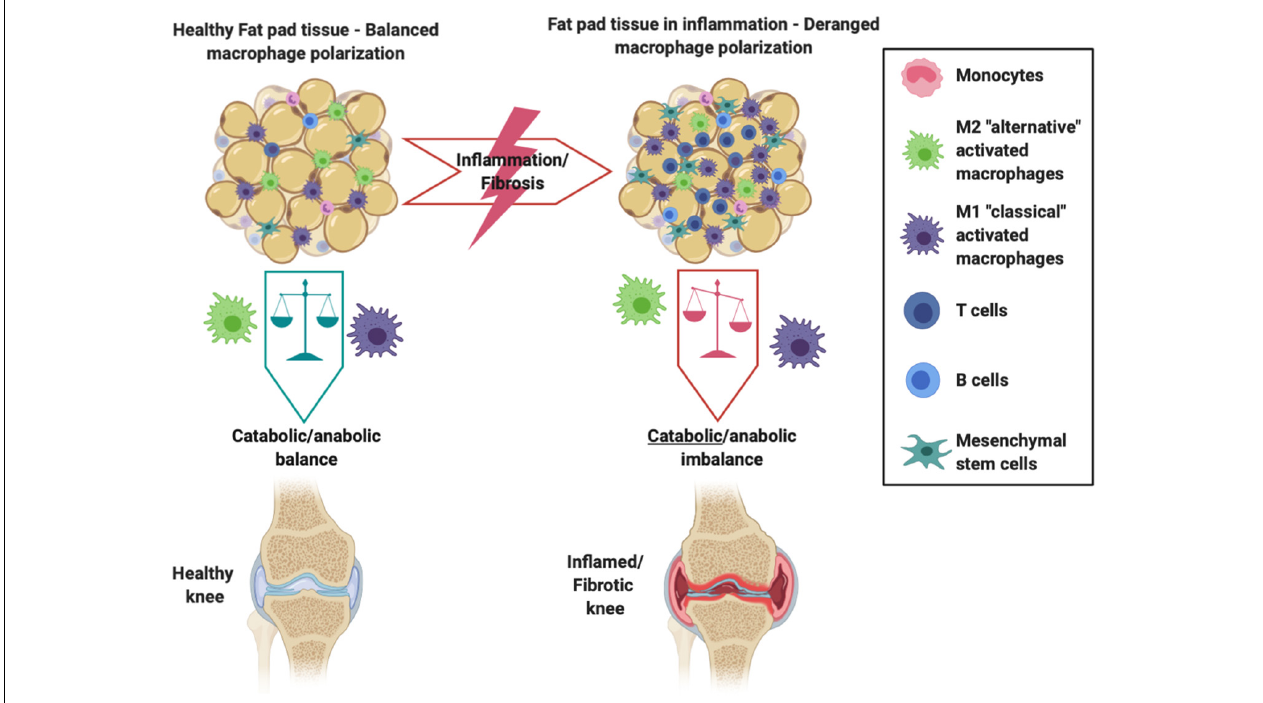
FIGURE 2 | Schematic showing the intricate balance between M1 and M2 macrophages within the IFP and synovium. Differentiated M2 macrophages exhibit anti-inflammatory effects and preserve the health of the joint, whereas an imbalance favoring M1 macrophages promotes the IFP’s secretion of pro-inflammatory cytokines and catabolic factors that are seen within an inflamed/fibrotic